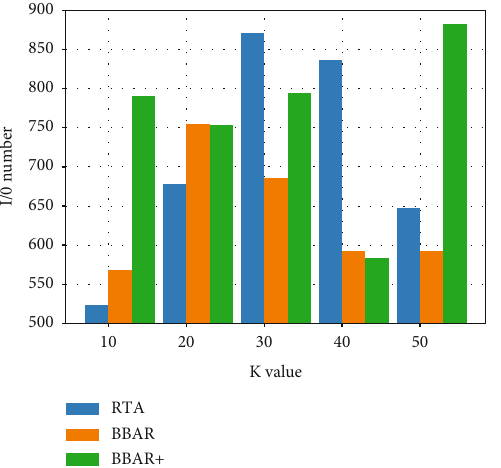
Figure 2: Comparison of I / O performance of various